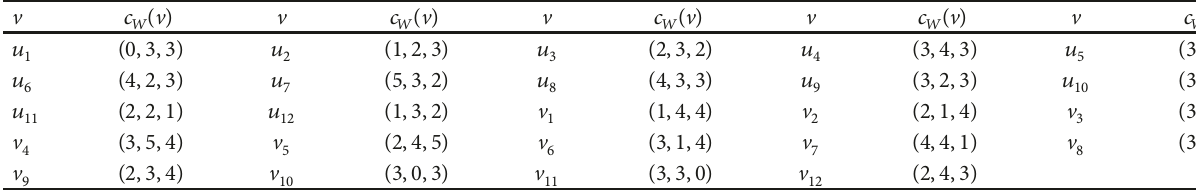
Table 13: The code 𝑐 𝑊 ( V ) of V with respect to 𝑊 = {𝑢 1 , V 10 , V 11 } in 𝑃(21,7)